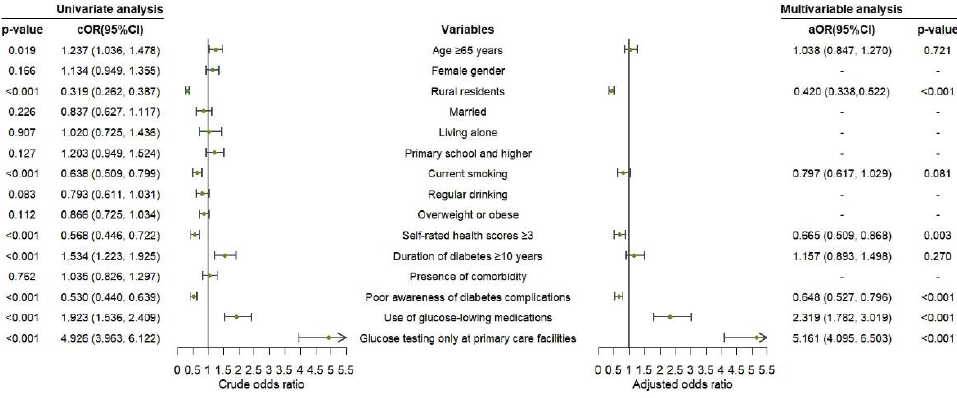
Figure 2. Logistic regression analysis on factors associated with regular follow-up attendance among T2DM patients at moderate to high CV